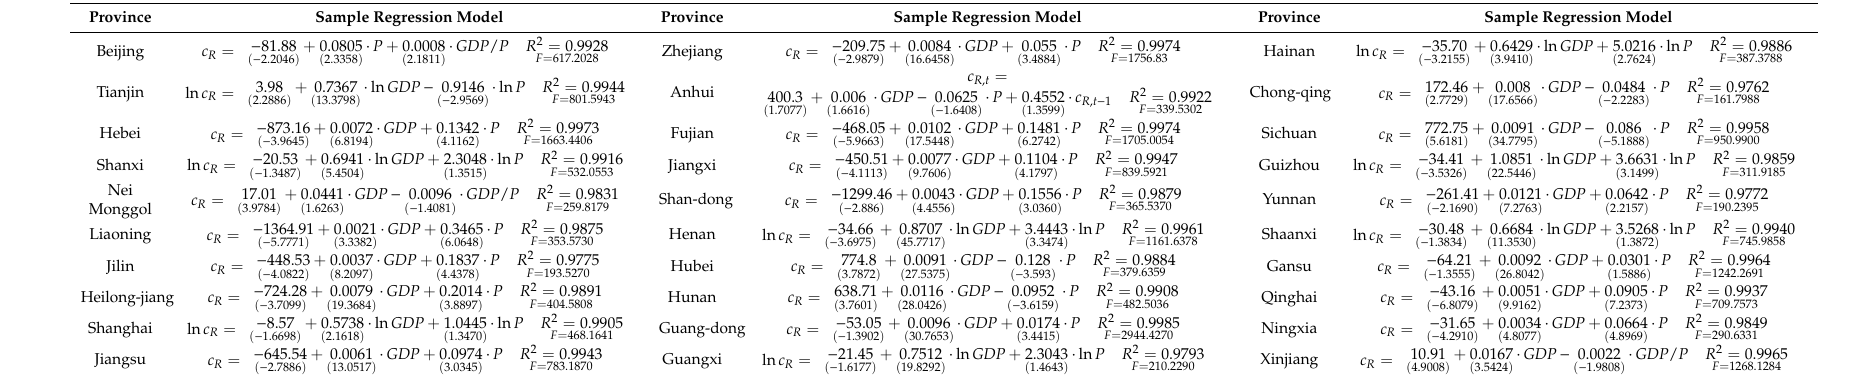
Table A2. Sample regression models of residential household electric